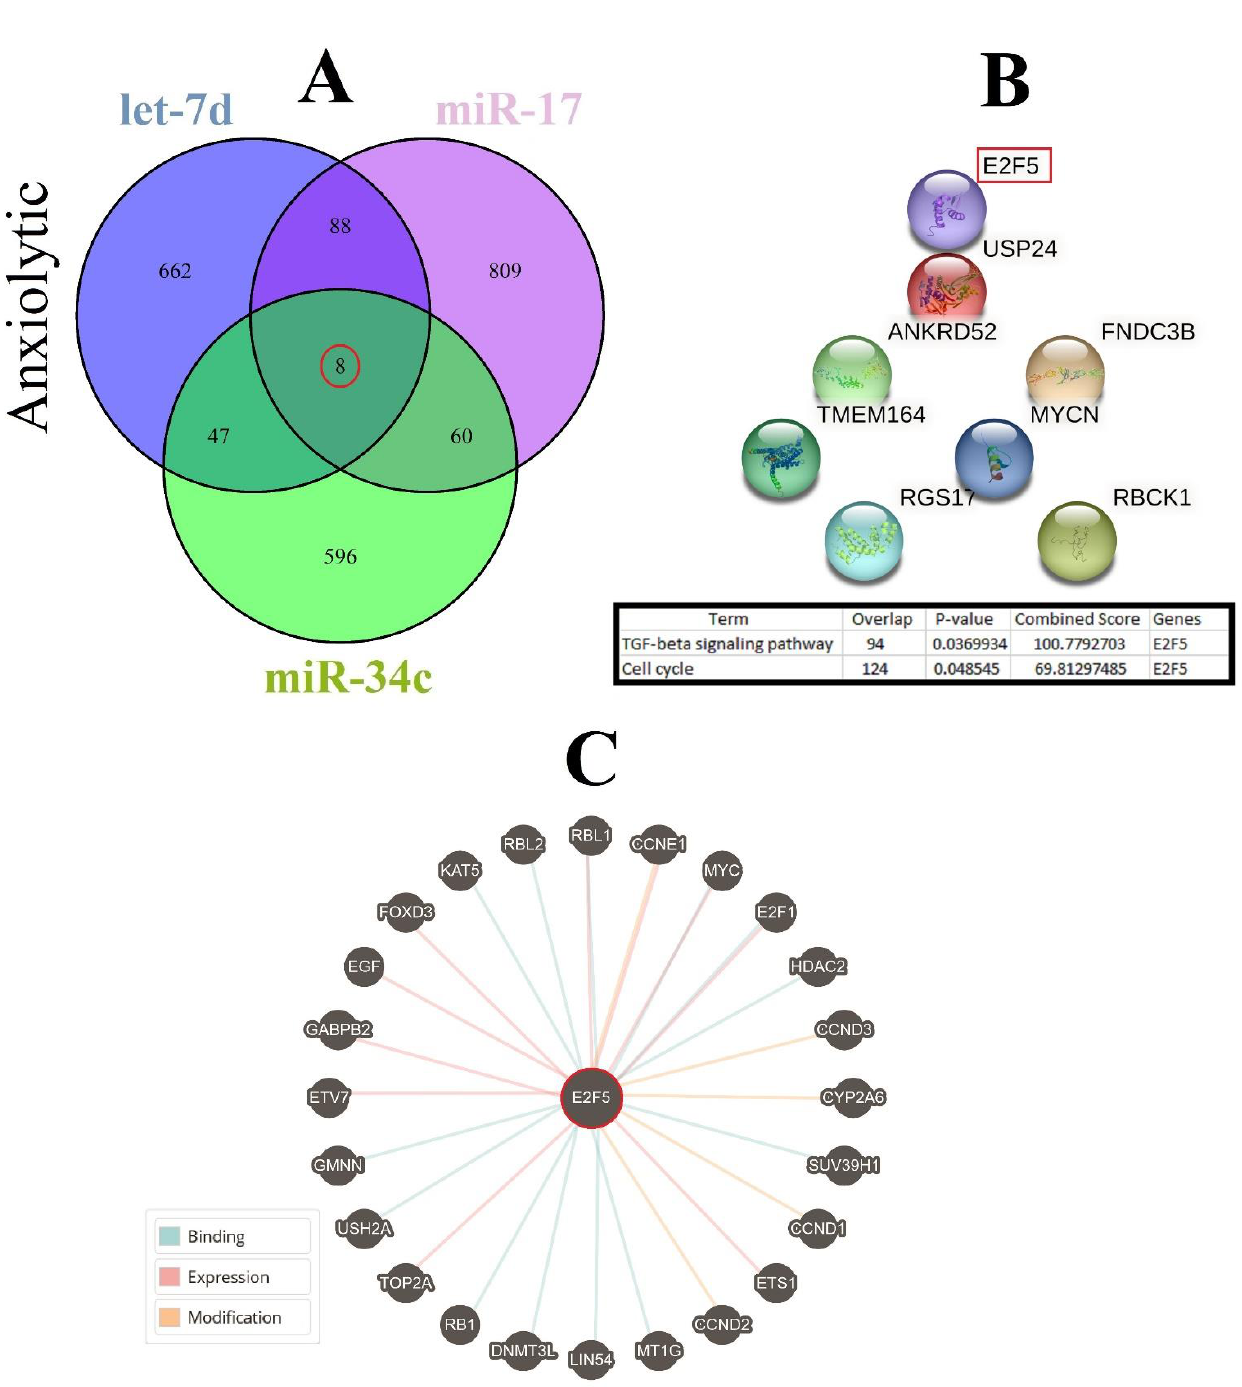
Figure 5. Common gene targets of highlighted anxiolytic miRNAs (miR-34c, Let-7d, and miR-17), their PPI, and protein targets. ( A ) Target prediction of highlighted anxiolytic miRNAs and selection of shared genes. ( B ) PPI of the common eight genes and selection proteins with a higher rank (E2f5). Hub genes were determined via the KEGG database in Enrichr, and information is indicated in a table. ( C ) Protein interaction of anxiolytic ’s common gene targets with other proteins.